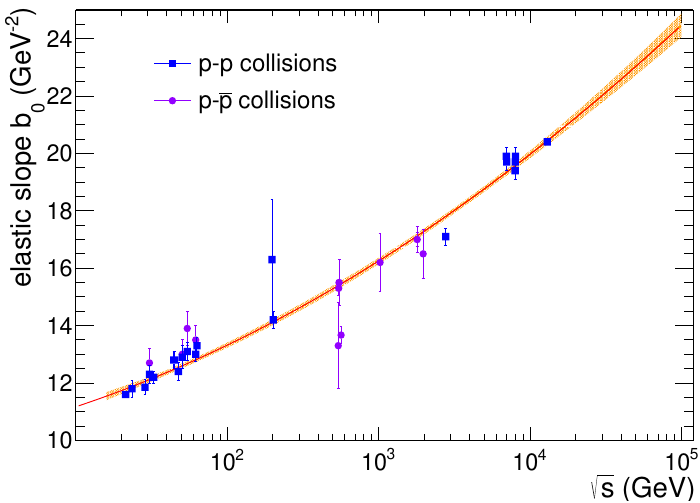
p s have been slightly shifted to the left or ) + C ln 2 ( s ), with NN NN